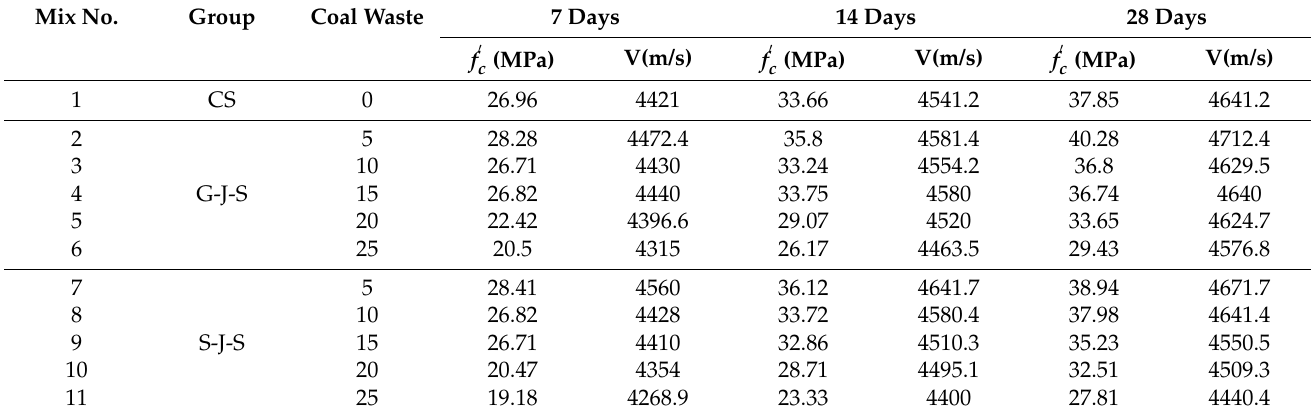
Table 5. Test results of ultrasonic pulse velocity (UPV) and compressive strength of concrete specimens. Mix